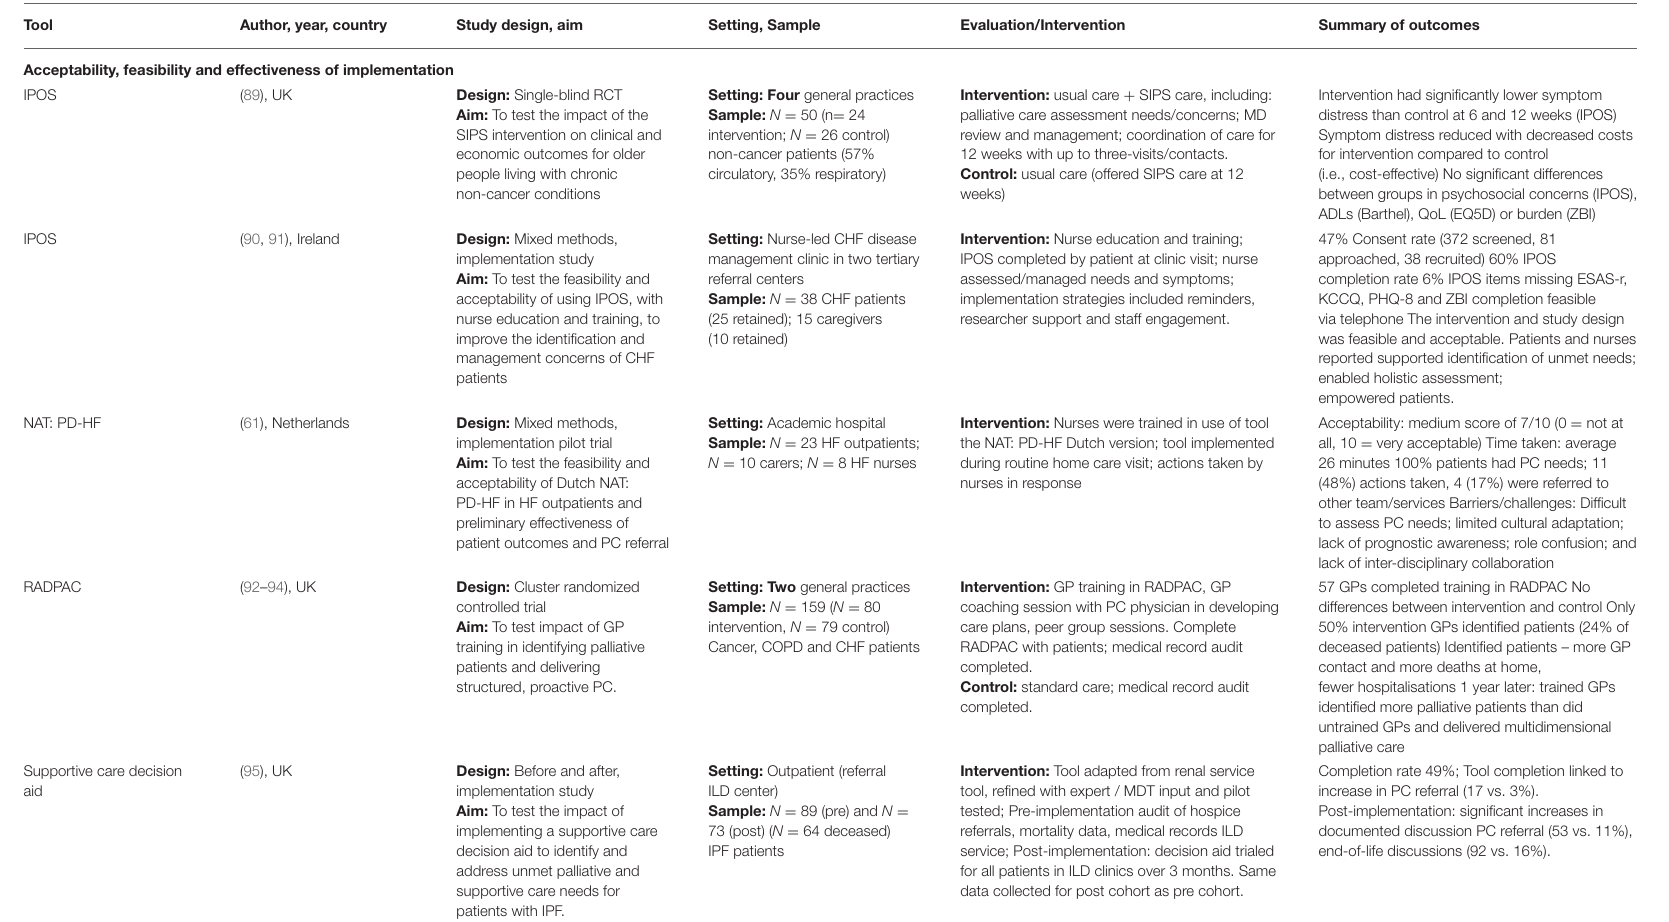
Setting: Outpatient (referral ILD